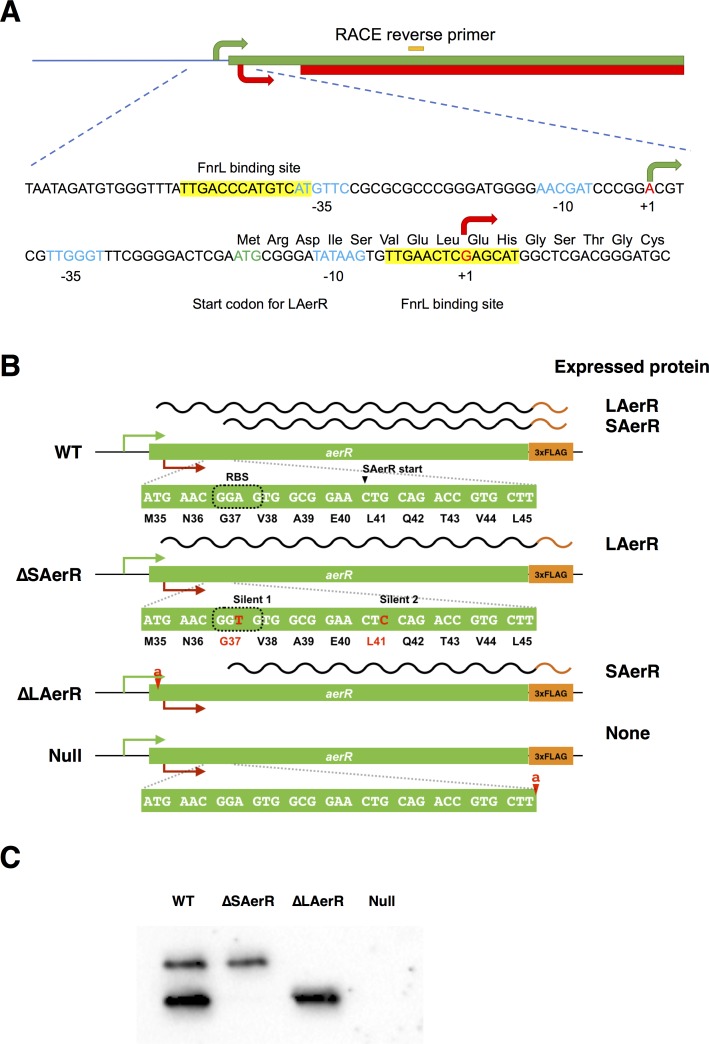
Summary of AerR translation start sites and AerR mutant construction.(A) WT strain expresses both LAerR (green bar) and SAerR (red bar), from Met codon one and Leu codon 41 respectively. The two transcription start sites are indicted as a green arrow and a red arrow as defined by Sanger sequencing of the 5’-RACE experiments. Putative −35 and −10 promoter recognition sequences in blue with yellow highlighted sequences denoting FnrL binding sites. (B) An ∆SAerR strain that expresses only LAerR, contains two silent mutations indicated in red text. One is within an internal ribosome binding site used for short AerR translation and a second is at the SAerR initiation codon L41 codon. ∆LAerR strain that expresses only SAerR, has one nucleotide insertion downstream of M1 codon to stop LAerR translation. A null AerR strain was constructed that does not express any AerR isoform by insertion of one nucleotide downstream of the L45 codon. (C) AerR-FLAG expression pattern in the three AerR mutants along with a WT control.